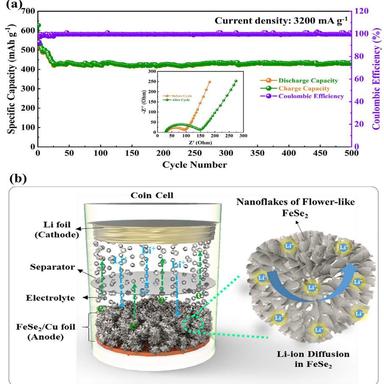
(a) Long-term cycling stability of the FS-based anode at a high current density of 3200 mA g−1 and (b) coin-cell model along with Li-ion diffusion paths/charge transportation of the FS-based anode during the energy storage process.